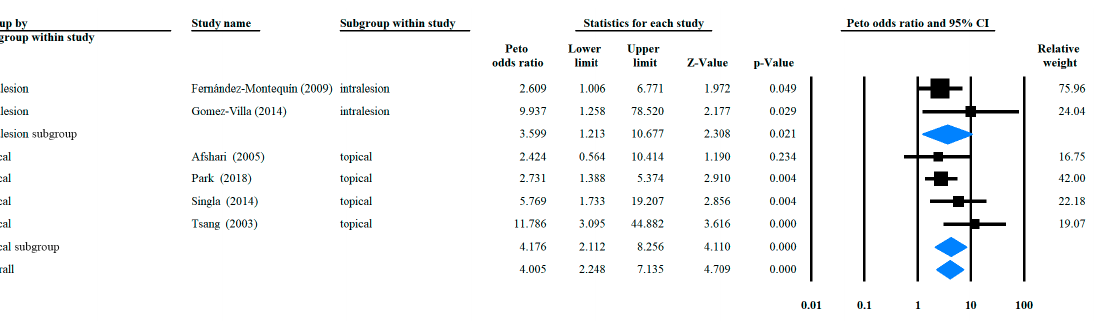
Figure 2. Forrest plot of complete healing rate categorized by different administration routes.